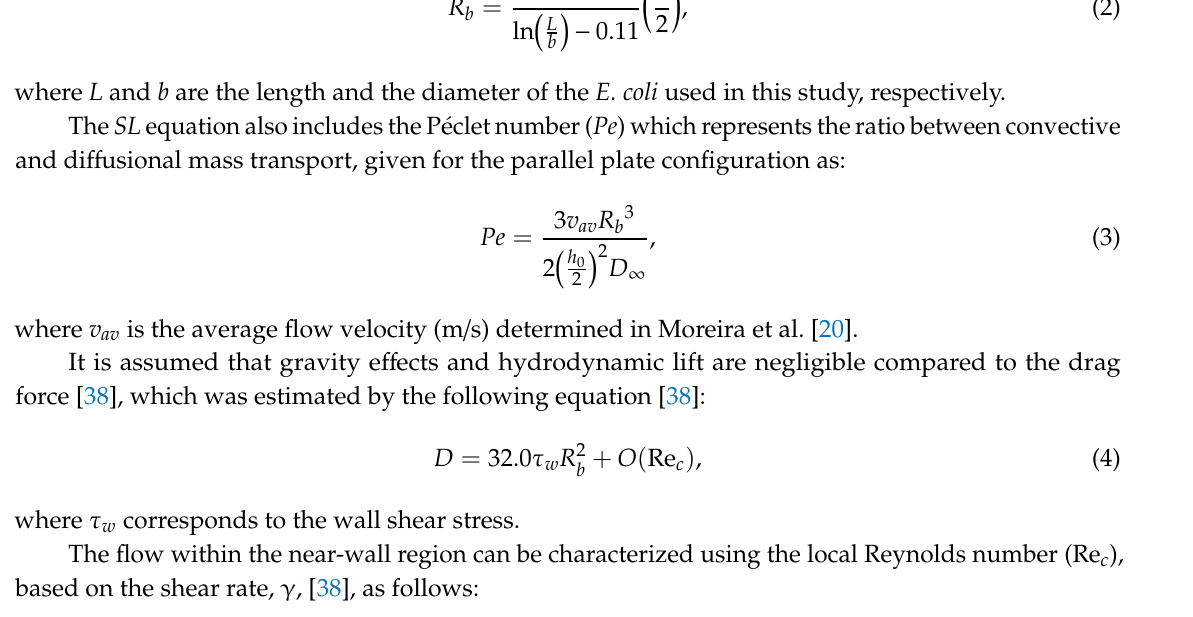
Figure S1: Steps of the method. From left to right: initial image, inverted image and maxima; R scripts—Relative positions script and Histogram script; Code 1—Cell adhesion analysis; Code 2—Surface coverage; Table S1: Shear rate and wall shear stress at the di ff erent flow rates tested (determined by Computational Fluid Dynamics) and examples of biomedical scenarios where these shear rates can be